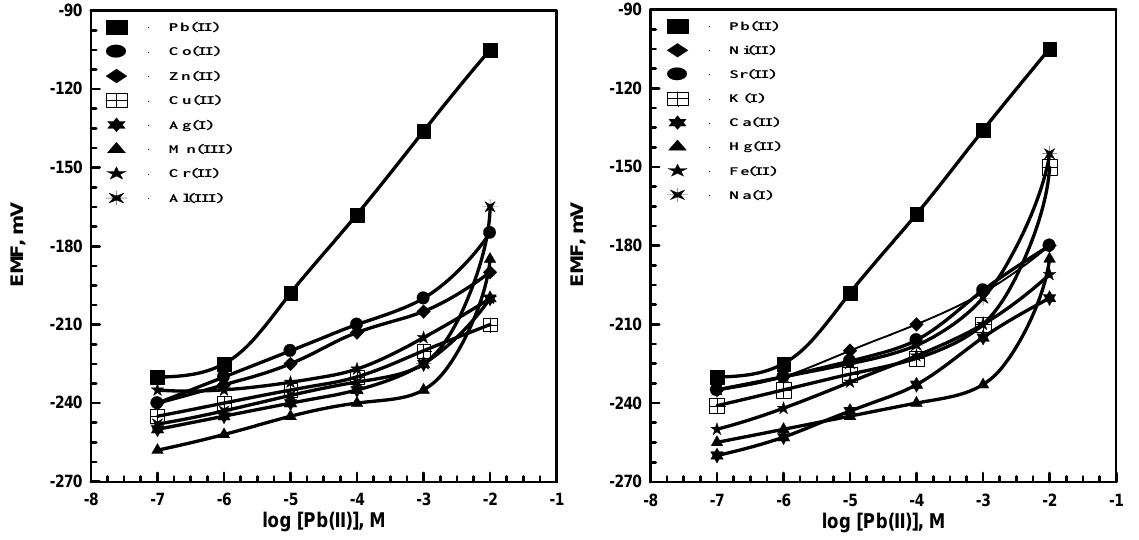
Figure 4. Potentiometric responses of lead membrane sensors based on (PT) with additive as ionophore toward several metal